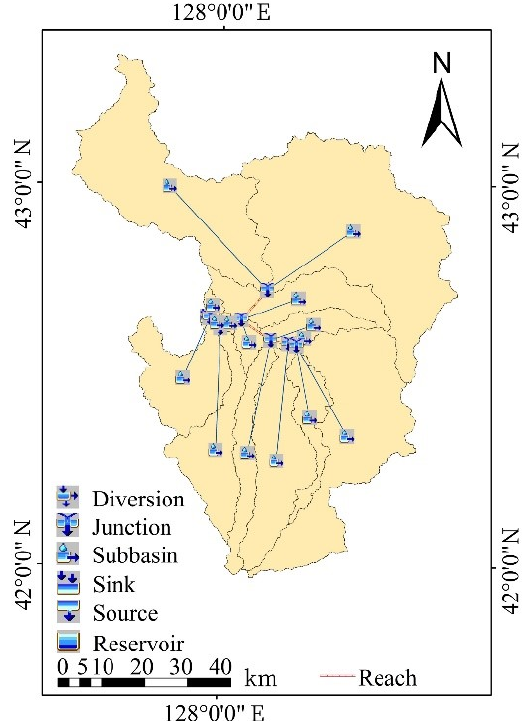
Figure 3. HEC-HMS model